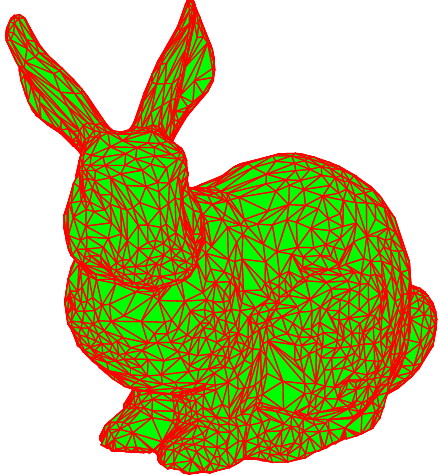
Figure 2. STL triangular patch model.